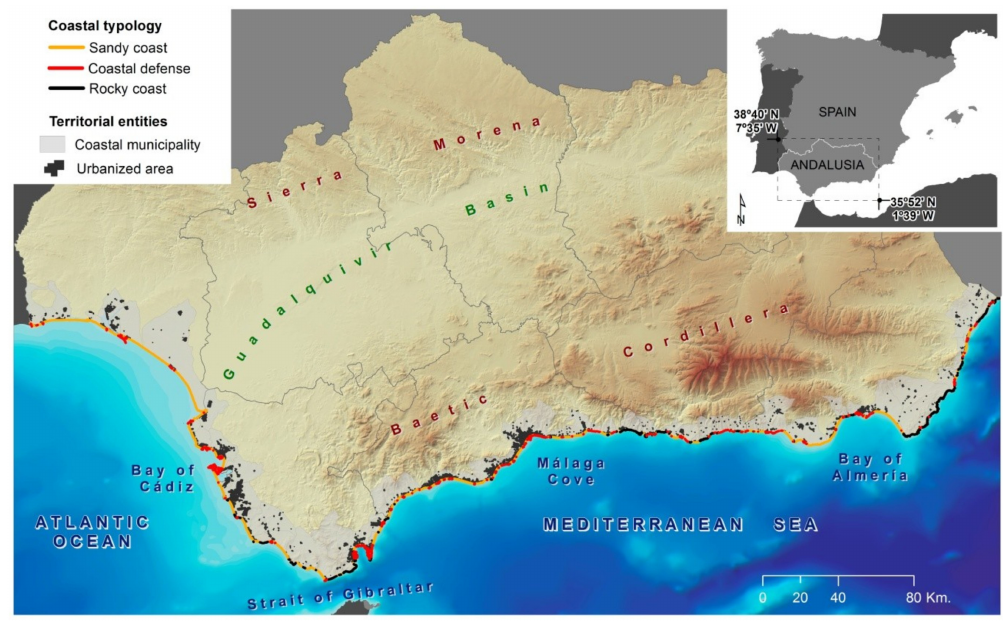
Figure 1. Location of the study